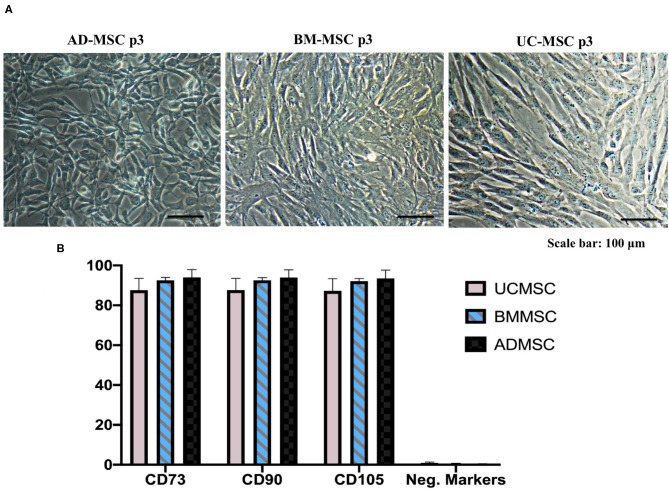
Human primary mesenchymal stem cells isolated from AD, BM, and UC at passage 3 of cell culture. (A) Typical morphology of MSCs was captured under Nikon Inverted Microscope Eclipse Ti-S. (B) Expression of MSC markers (n = 5) were analyzed using flow cytometry approach and Human MSC Analysis Kit (BD Biosciences). Positive markers include CD90, CD105, and CD73, and negative markers include CD45, CD34, CD11b, CD19, and HLA-DR. ADMSC, Adipose tissue-derived MSCs; BMMSC, Bone marrow-derived MSCs; UCMSC, Umbilical cord-derived MSCs. Error bars indicate ± SD.